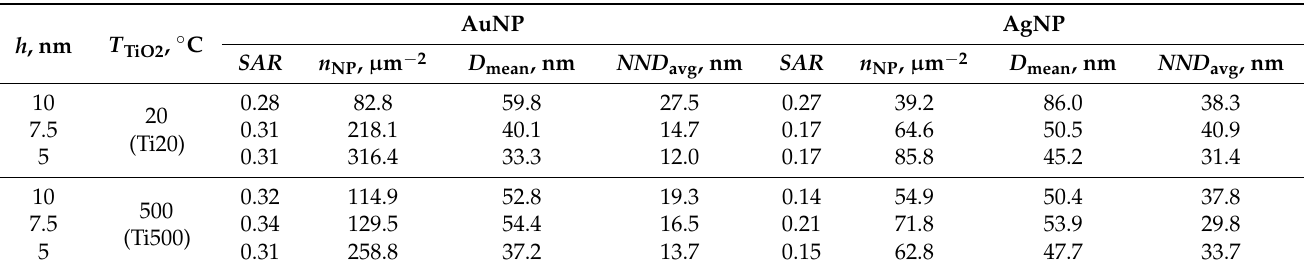
Table 1. Characteristics of AuNP and AgNP after annealing metal/TiO 2 thin films systems: surface area ratio ( SAR ), density of NP ( n NP ), mean diameter of NP ( D mean ), and distances between-NP (border-to-border) to all their neighbors ( NND avg ).